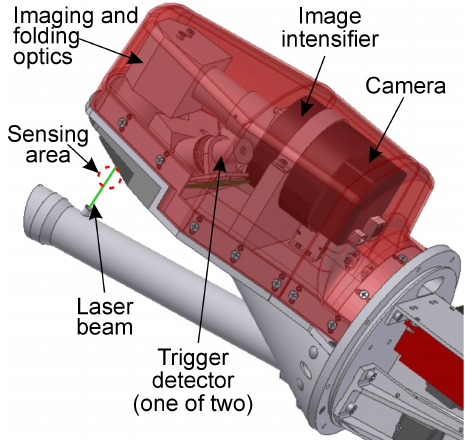
Fig. 3. Schematic view of the head of the SID-3 instrument. Only a small part of the instrument inside the PMS canister is visible (lower right). The sensing area shown is positioned 17.4mm from the faceplate of the